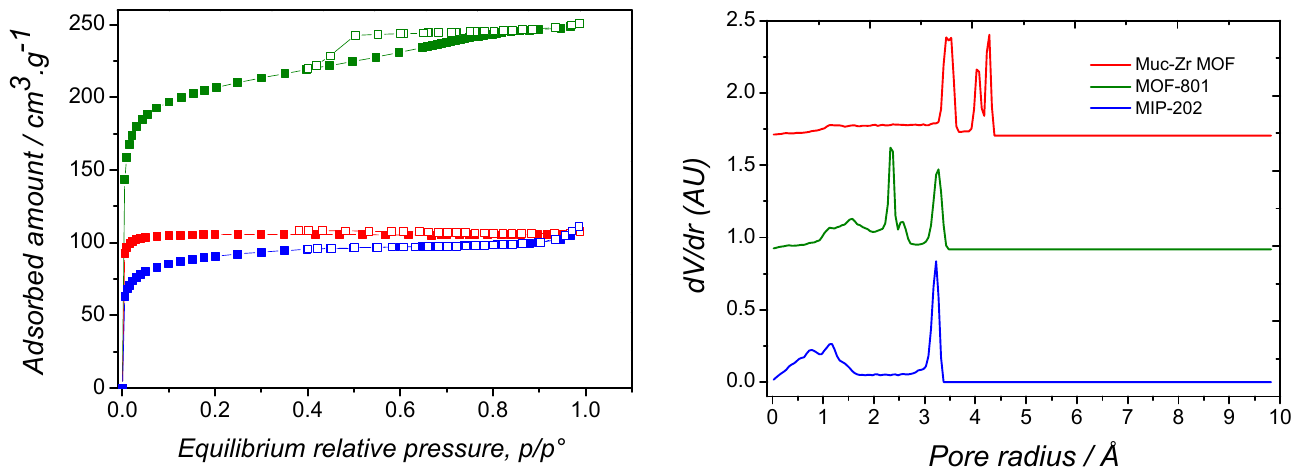
Figure 5. ( Left ) Nitrogen sorption isotherms. (Green) MOF-801, (red) Muc-Zr MOF, (blue) MIP-202. Open symbols correspond to the desorption branches of the sorption isotherms. ( Right ) Pore size distribution of (red) Muc-Zr MOF, (green) MOF-801, (blue) MIP-202.